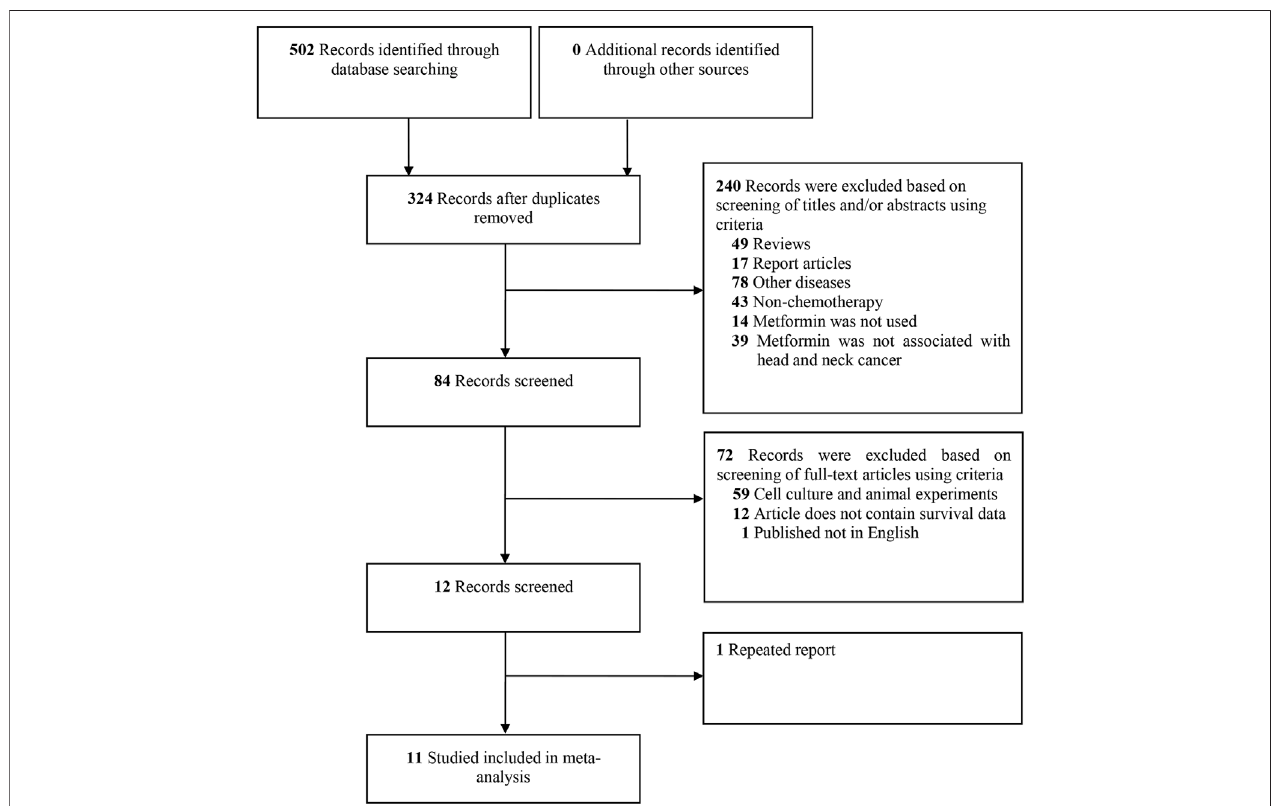
FIGURE 1 | Flow diagram of studies search and selection criteria for systemic review and